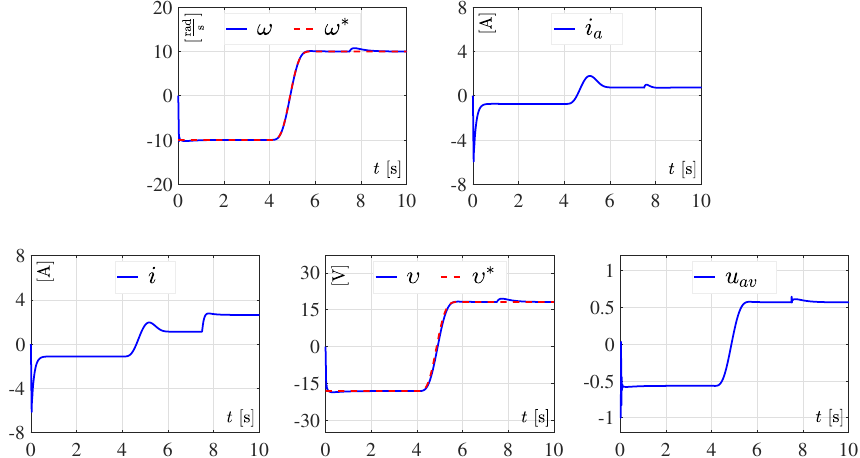
Figure 14. Simulation results associated with the designed flatness-based control (3), when ω ∗ is of the Bézier type (22), and the abrupt variations in load R , declared in (26), are introduced into the